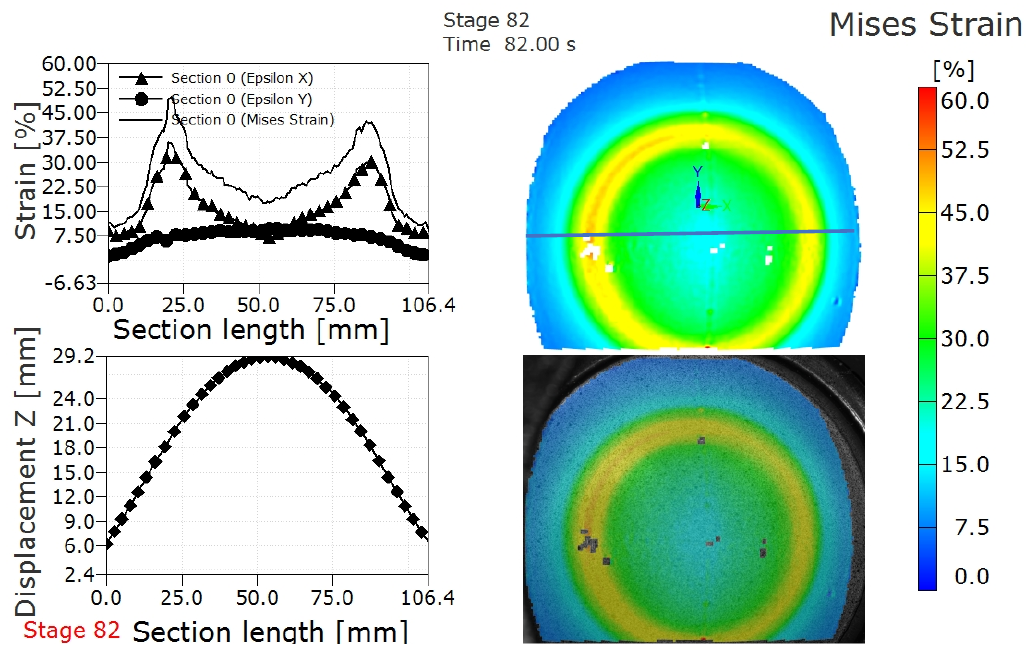
Figure 5. Strain distribution and displacement distribution along the section and Mises strain contour map in the deformed AA5754 TWBs with thicknesses of 3 mm prior to fracture. The blue line in upright is the s